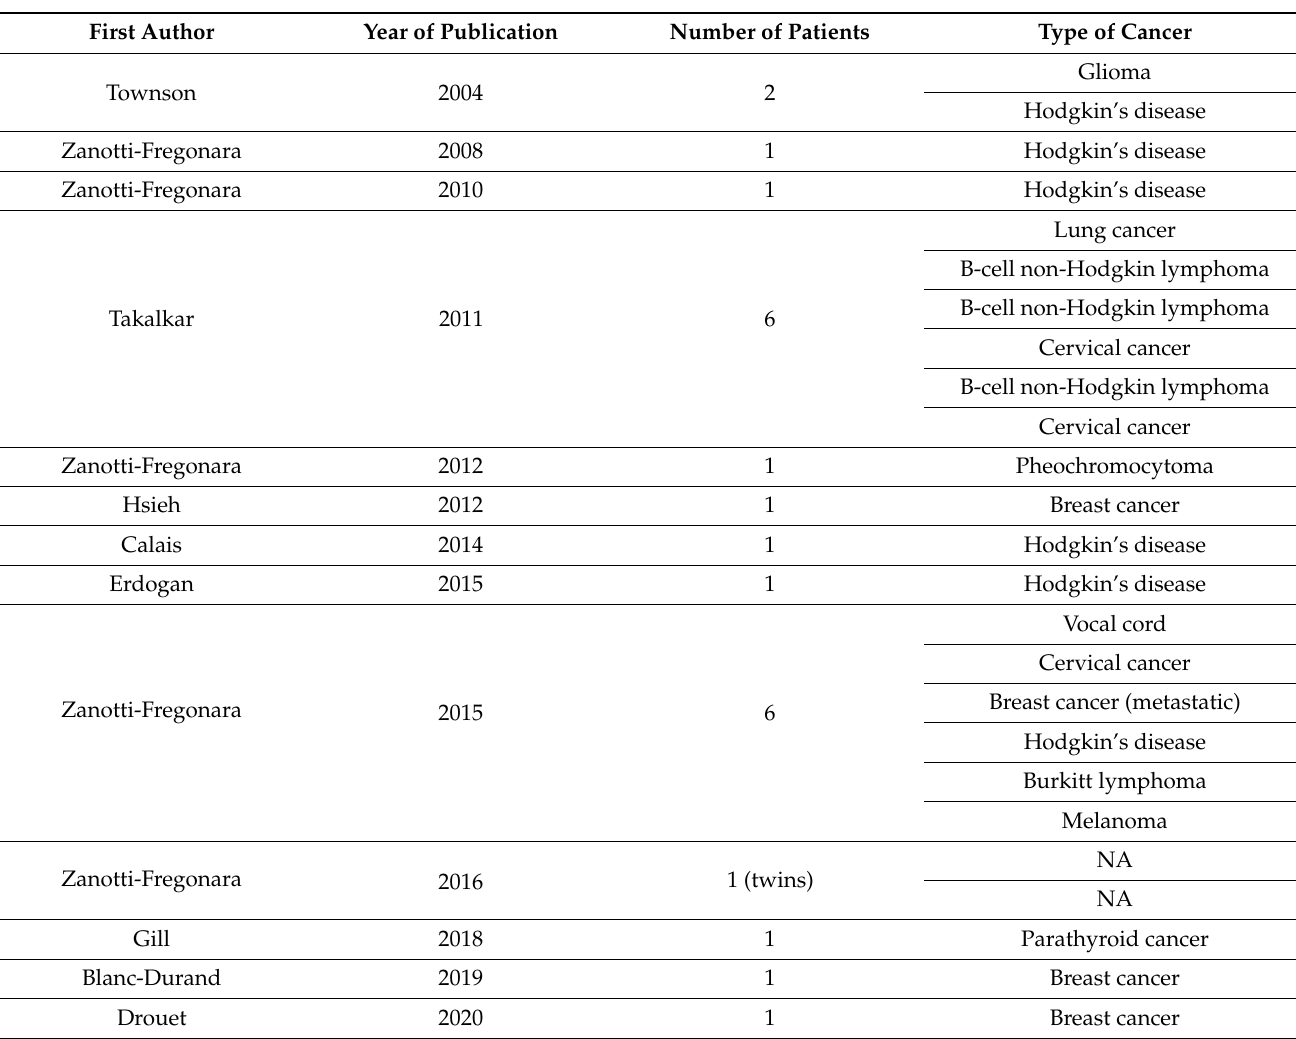
Table 1. Summary of observational clinical studies on PET examination use during